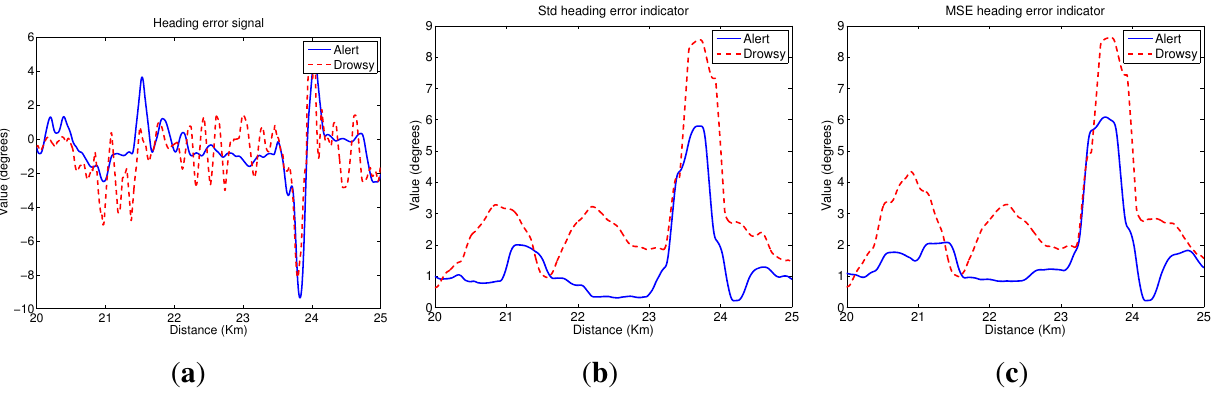
Figure 7. Heading error indicators. ( a ) Heading error signal; ( b ) the standard deviation of the heading error ( ST D he ) and ( c ) the mean squared error of the heading error ( MSE he